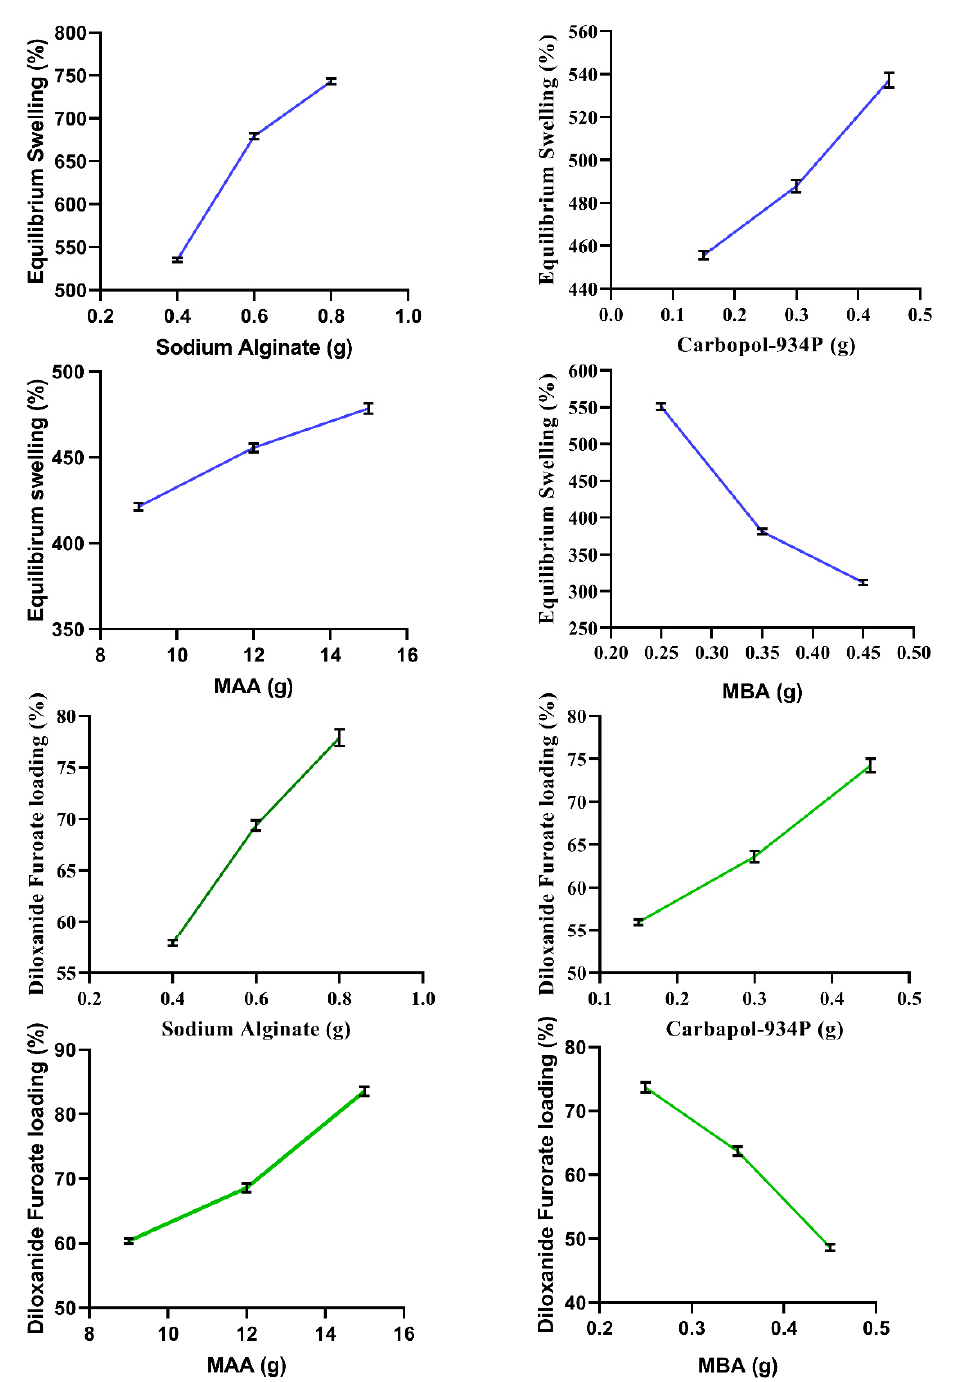
Figure 3. Effect of Na-Alg, CP-934P, MAA, and MBA on the equilibrium swelling (%) and DF load- ing (%) into developed